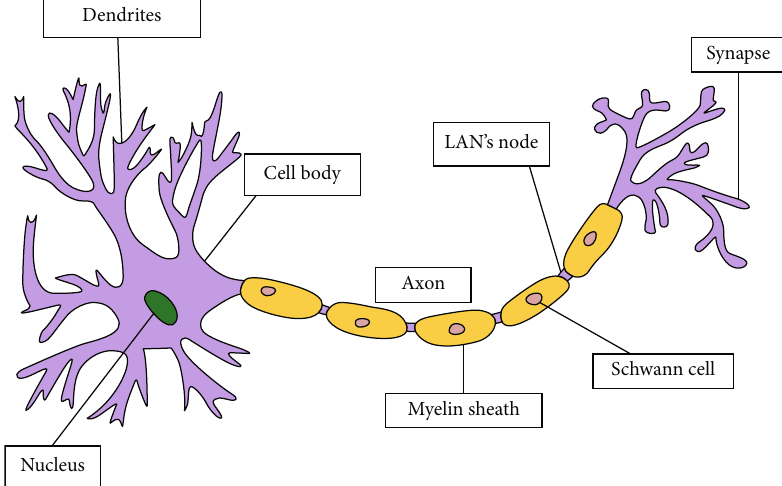
Figure 2: Schematic diagram of the biological structure of a neuron.